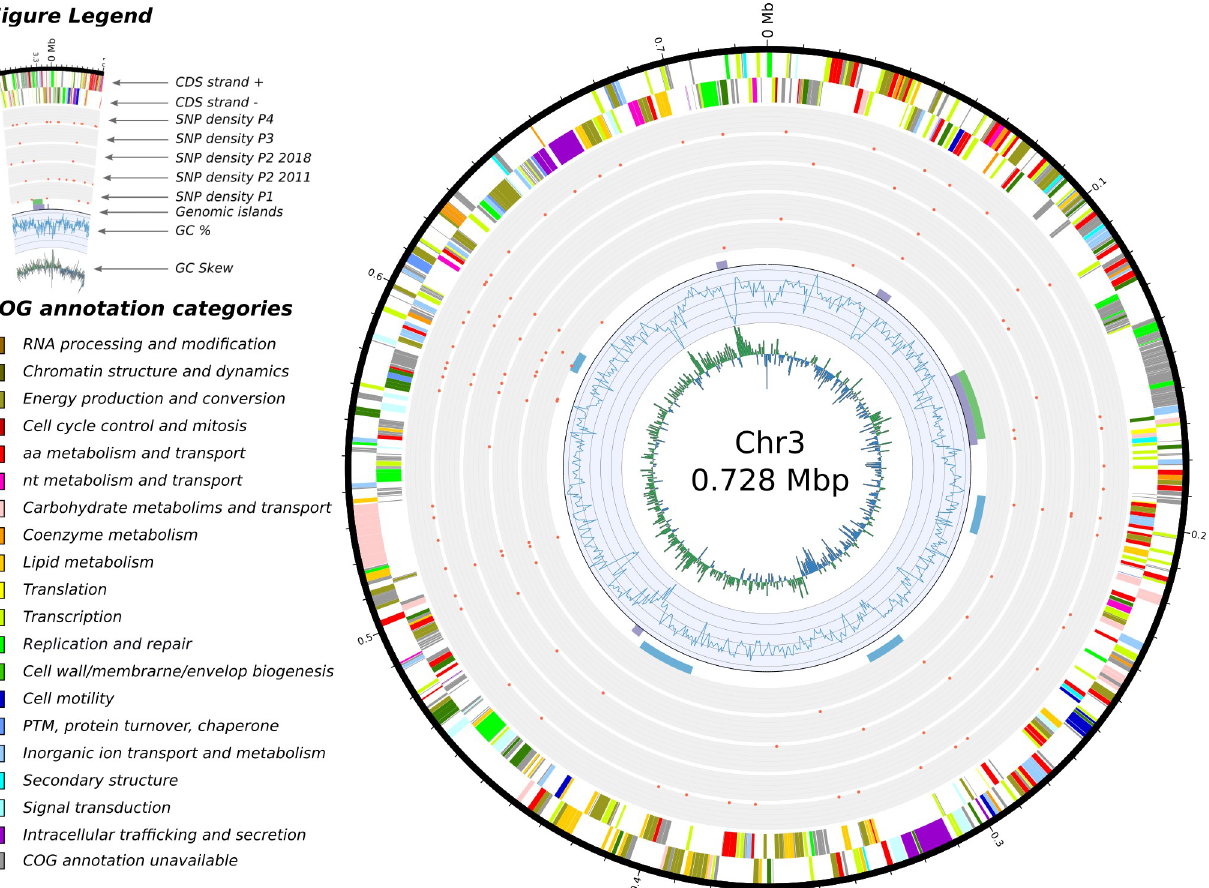
Fig 7. Feature of chromosome 3 and SNP densities comparisons. In concentric circles, from the center and outward are depicted: 1) the GC skew, 2) the GC content, 3) the genomic islands detected by the software IslandViewer 4 (in purple), the prophages detected with Phaster (green) and the secondary metabolites identified by antiSMASH (in blue), 4) a total of five SNP densities, we separated the isolates from 2011 and the isolate from 2018 in patient 2 as we regard them as two separate acquisition events, 5) and 6) the annotated features found on the negative and positive strand respectively.